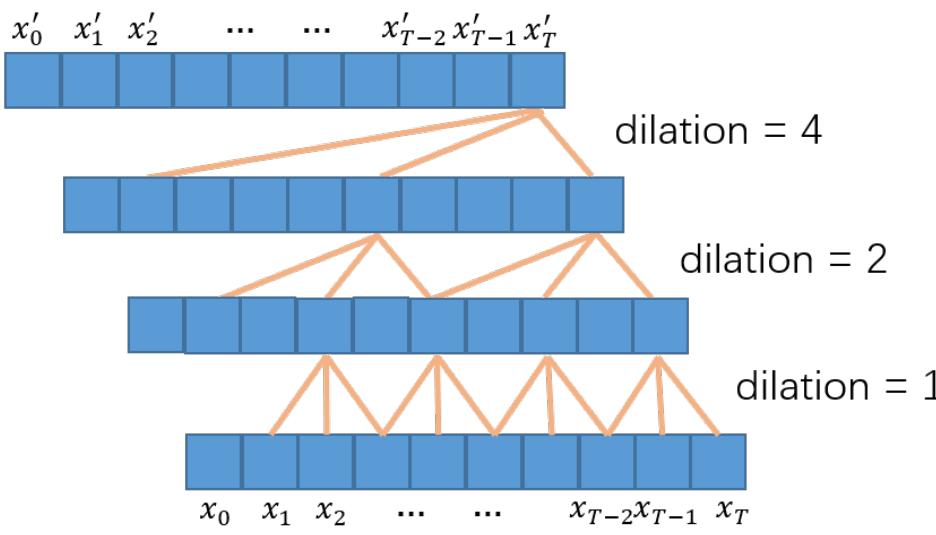
Figure 1. The visualization of a stack of dilated convolution layers which transform the input sequence x into x (cid:48) with kernel size = 3. The dilation_base is set to be 2. 3 stacks of dilated conv-layers acquire a reception field of 15